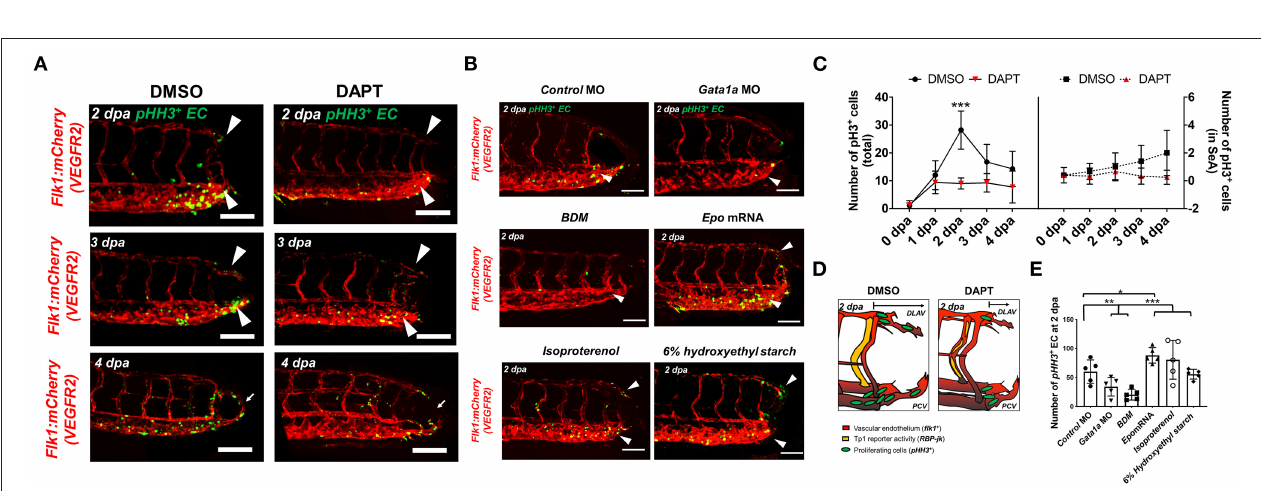
FIGURE 2 | isoproterenol treatment (100 µ M) and 6% hydroxyethyl hetastarch promoted regeneration and vascular loop formation. Scale bar: 20 µ m. (C) Gata1a MO and BDM treatment reduced endothelial tp1 activity and impaired regeneration, whereas epo mRNA injection or isoproterenol treatment up-regulated endothelial tp1 activity in the amputated site (white arrowheads) and promoted vascular loop formation at 4 dpa (white arrows). Scale bar: 20 µ m. (D,E) Quantification of the proportion of embryos exhibiting loop formation and normalized area of vascular loop ( * p < 0.05, ** p < 0.005 vs. control MO, n = 20 for each group to assess proportion, n = 5 for each group to assess area of vascular loop). Scale bar: 20 µ m.